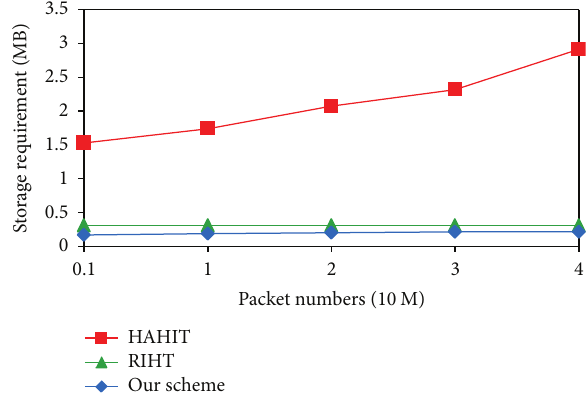
Figure 8: Comparison of the maximum storage requirements.